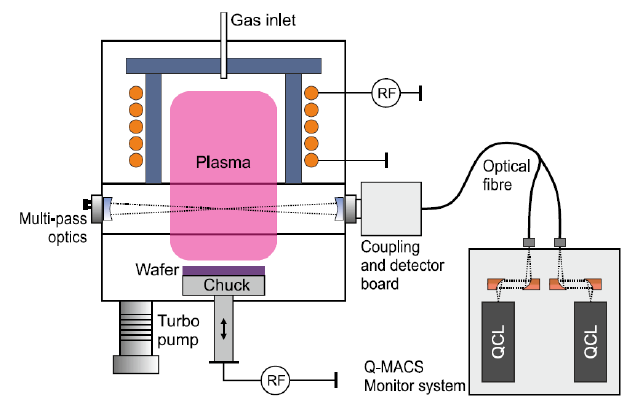
Figure 15. Experimental arrangement of the inductively coupled plasma (ICP) reactor, Oxford Plasmalab system 100, combined with a Q-MACS Process fiber system containing two pulsed QCLs [58], © Springer Publishing. Reproduced with permission. All rights reserved.